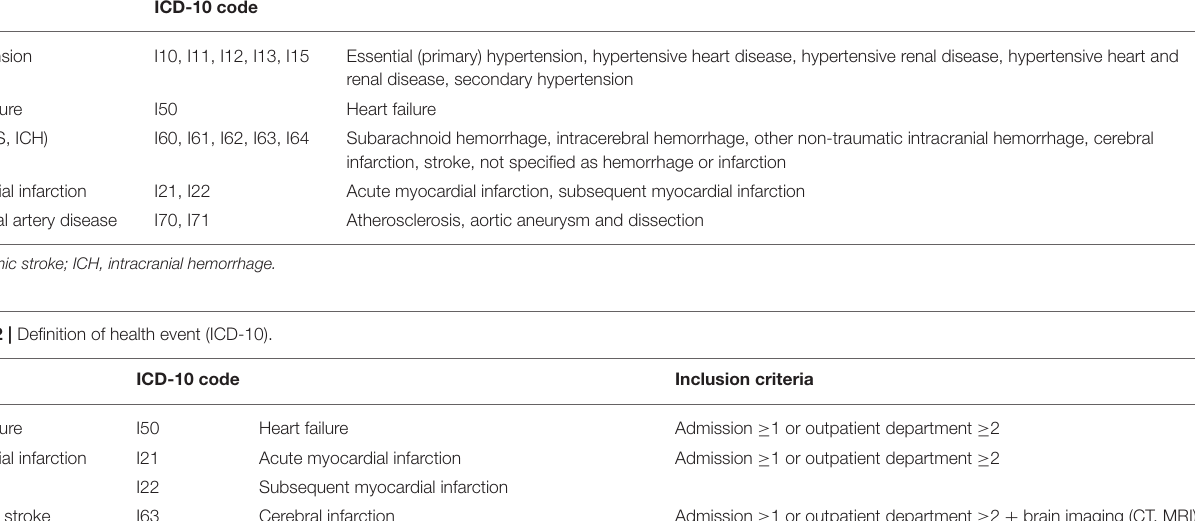
TABLE 1 | Definition of CHA 2 DS 2 -VAS c score components (ICD-10). Disease